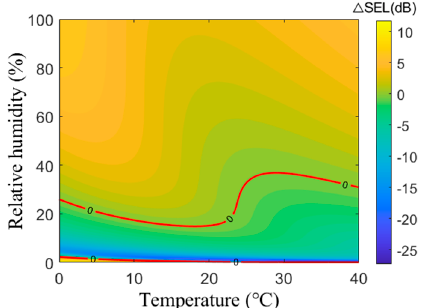
Figure 4. Meteorological effects on aircraft noise intensity. Absorption adjustment (difference in SEL with respect to that of a standard atmosphere).